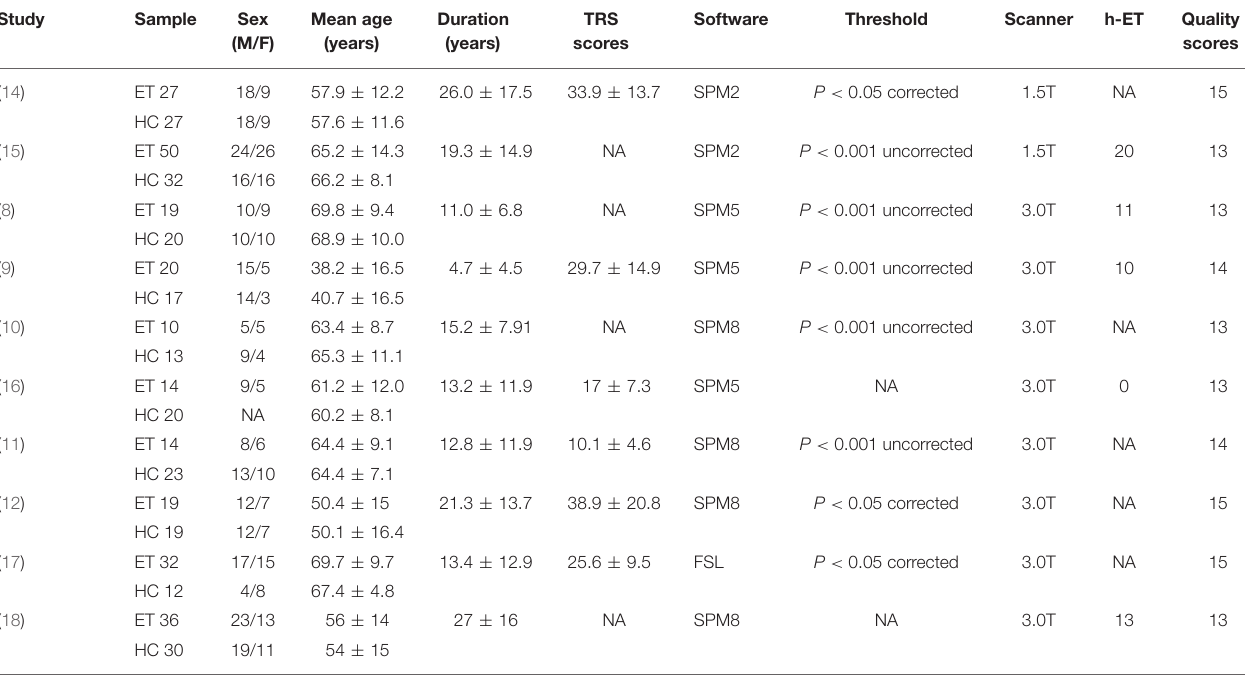
TABLE 1 | Characteristics of included VBM studies in the current